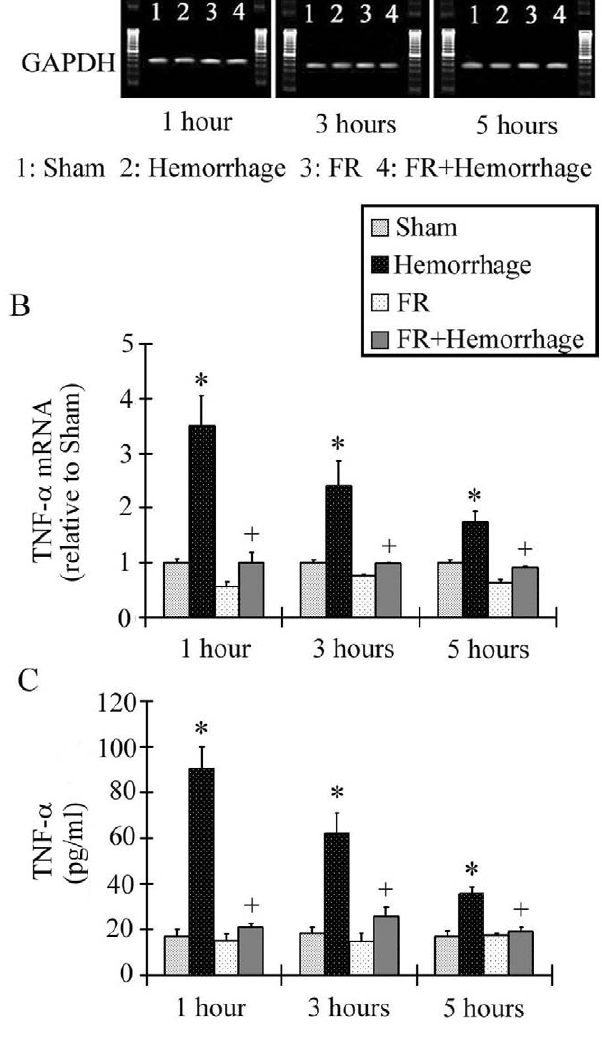
Figure 5. Changes in hepatic TNF- a expression after hemor- rhage. TNF- a mRNA was assessed by RT-PCR. Relative TNF- a mRNA expression levels, shown on the vertical axis in B, were expressed after normalization with GAPDH. The Hemorrhage group showed the greatest increase in TNF- a expression at 1 hour post-hemorrhage, and the levels were higher than in the Sham group for up to 5 hours. On the contrary, the TNF- a mRNA level in the FR + Hemorrhage group did not change significantly from the baseline value. The serum TNF- a level in the Hemorrhage group was significantly higher than baseline value at 1 hour after a hemorrhage and decreased subsequently, but was significantly higher than the Sham group at all timepoints post- hemorrhage, as shown in C. In contrast, the serum TNF- a level in the FR + Hemorrhage group did not show an increase from baseline throughout the experiment. Data are shown as mean 6 SE. n=5/groups, * p , 0.05 vs Sham, + p , 0.05 between Hemorrhage and FR + Hemor-